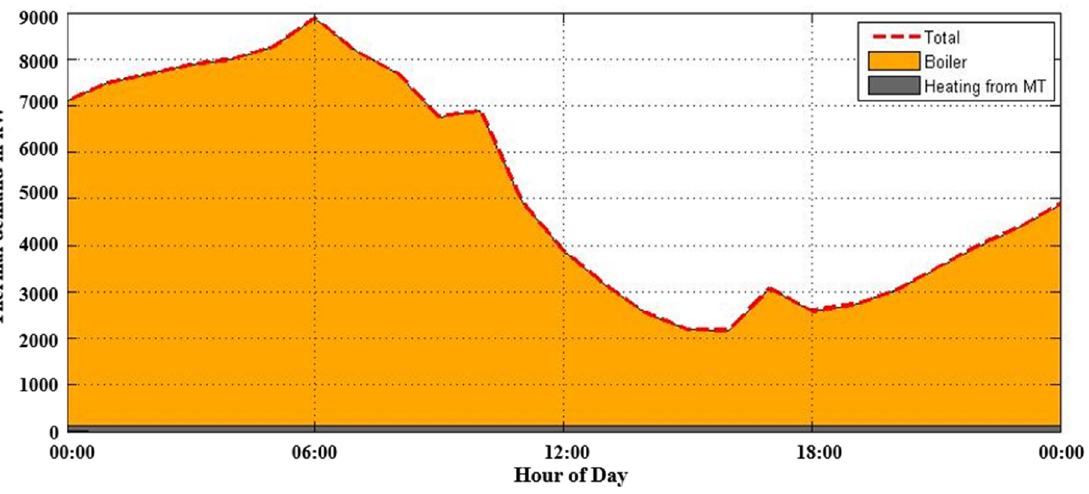
Figure 10. Only MT thermal output; 12 February 2013 (scenario 1).